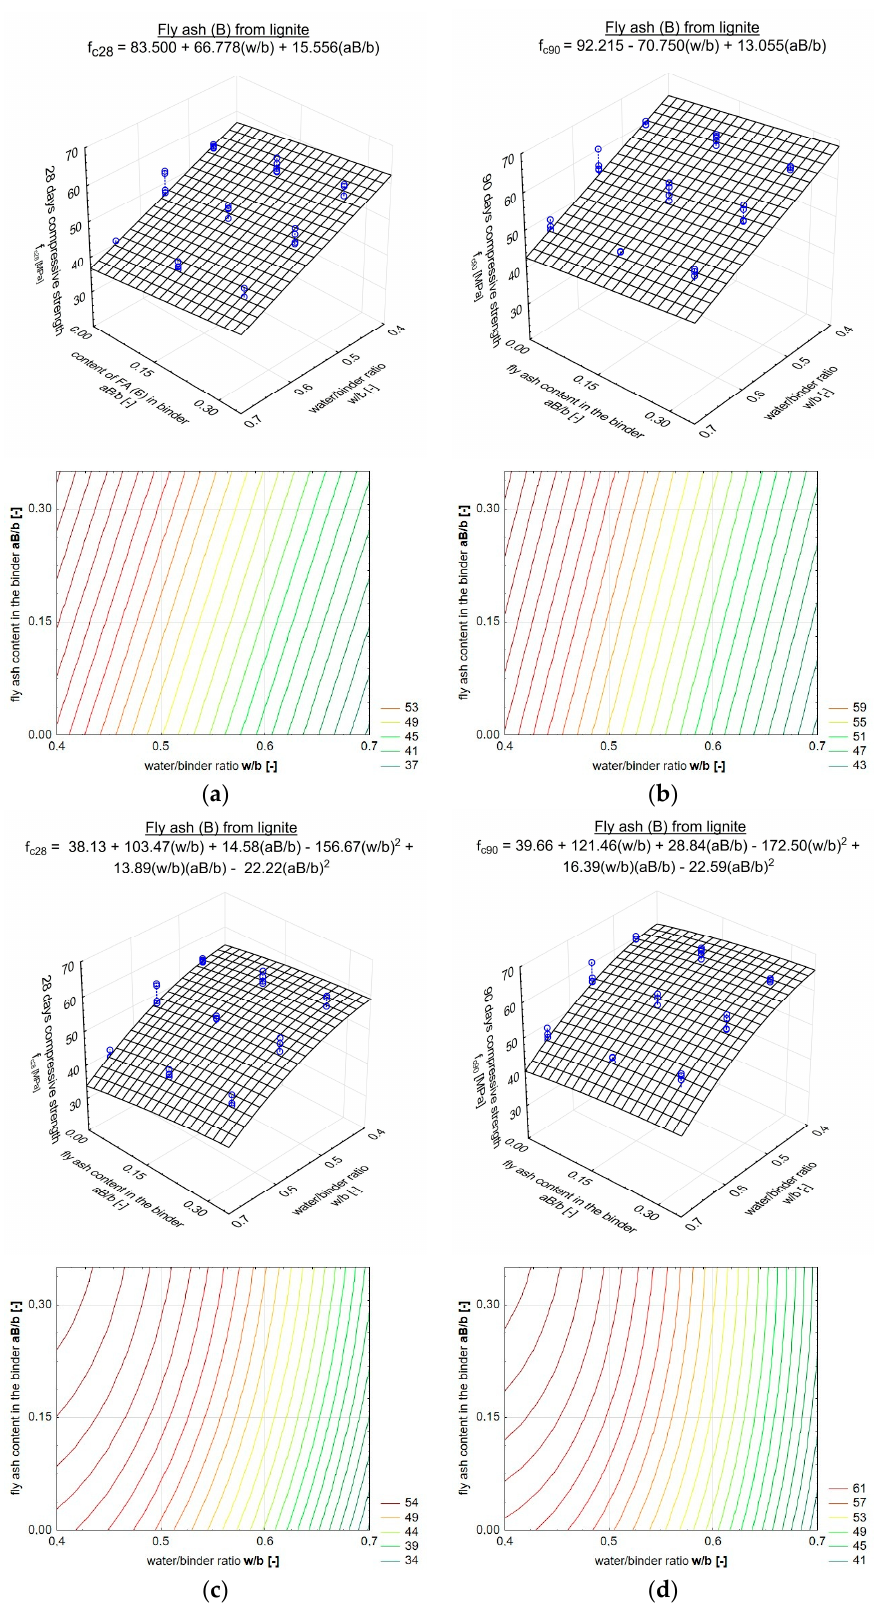
Figure 2. Compressive strength of concretes with fly ash addition B (lignite) after 28 ( a , c ) and 90 ( b , d ) days; test results approximated using a linear function ( a , b ) and a second-degree polynomial ( c , d